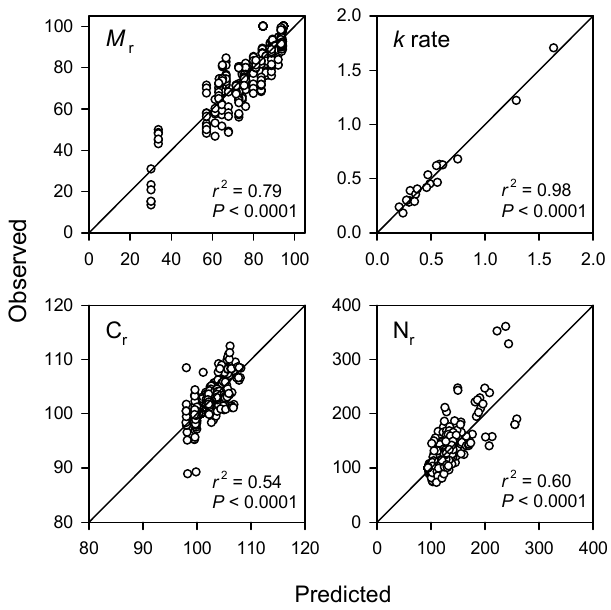
Figure 6. Modelled data using Eqs. (2–8) plotted against observed data: ( M r ) the percentage of remaining litter mass relative to the initial value, ( k rate) litter decomposition rate constant, and the per- centage of carbon (C r ) and nitrogen (N r ) content in litter relative to the initial value. For reference see 1:1 solid